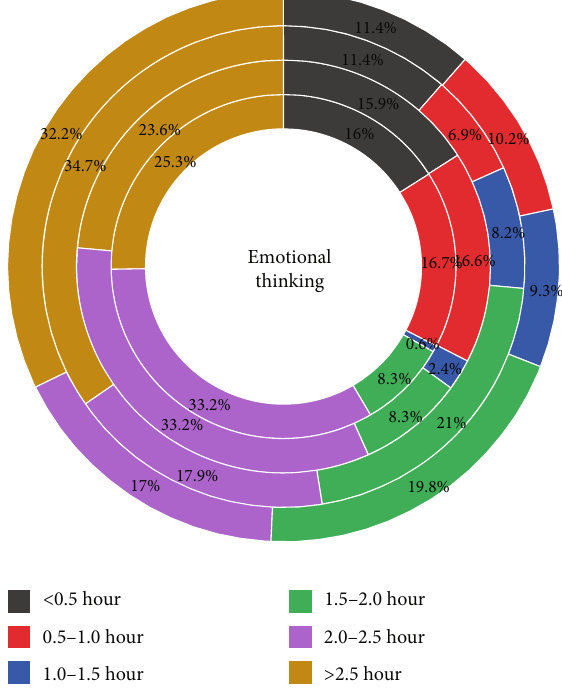
Figure 5: Emotional thinking memory